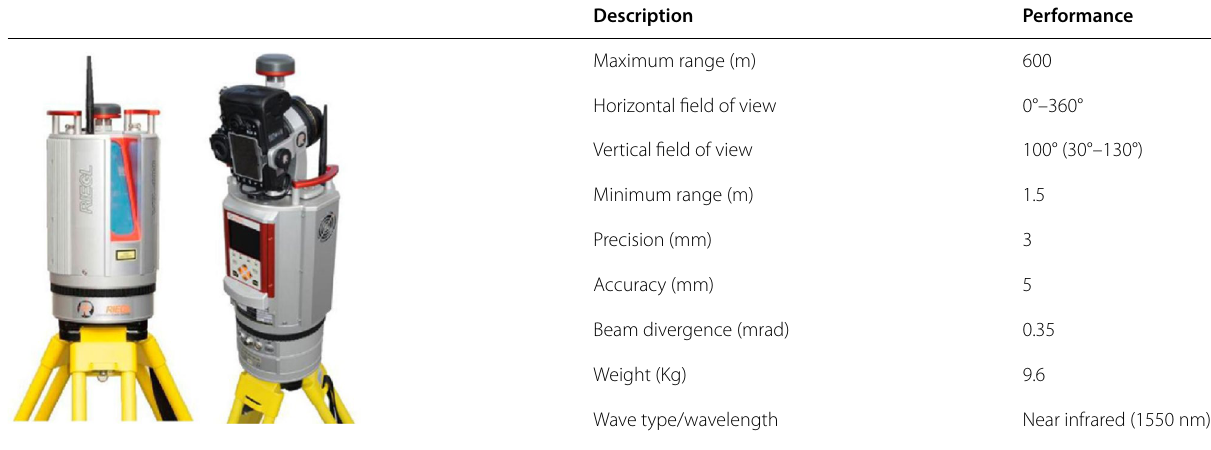
Table 1 Specification of RIEGL VZ-400 terrestrial laser